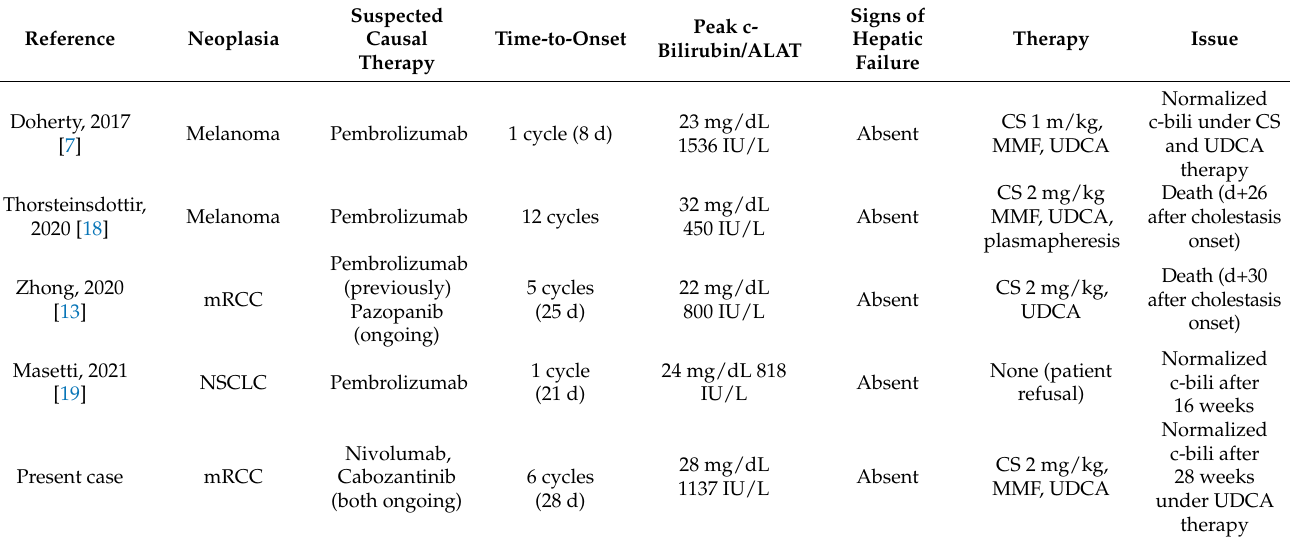
Table 1. Published cases of vanishing bile duct syndromes occurring during immune checkpoint inhibitor and/or tyrosine kinase inhibitor